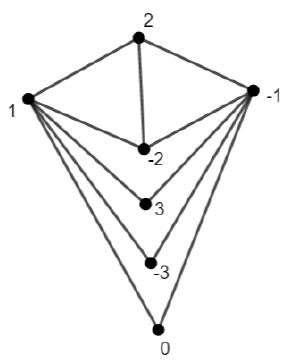
Figure 4: Integer cordial labeling of J